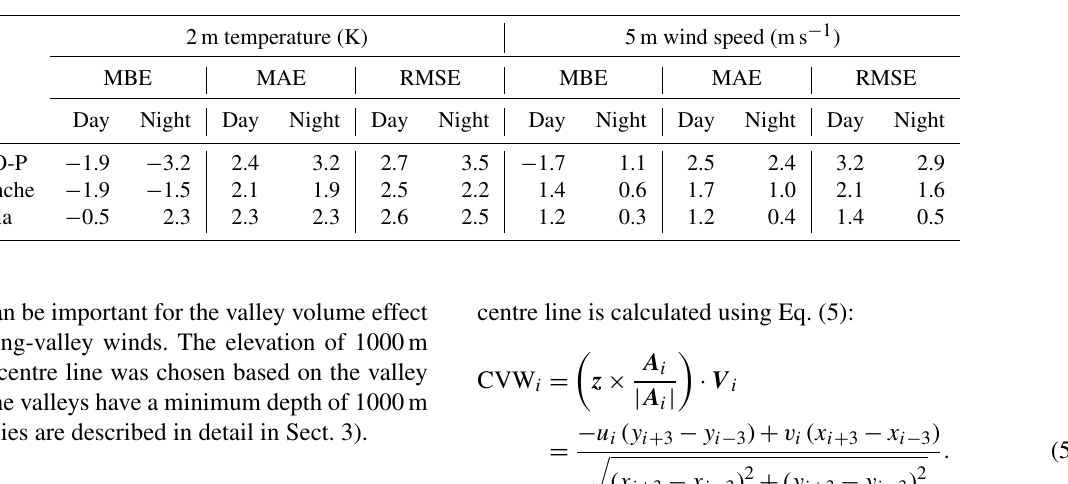
Table 2. WRF-modelled values compared to near-surface observations in the Khumbu Valley, showing the mean bias error (MBE), mean absolute error (MAE) and root-mean-square error (RMSE) of the 2m temperature and 5m wind speed separately for daytime (06:00– 18:00LT) and night-time (18:00–06:00LT).